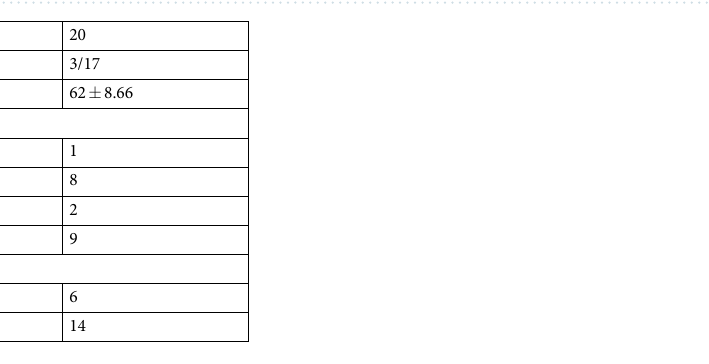
Table 1. Clinical description of the studied patient cohort with